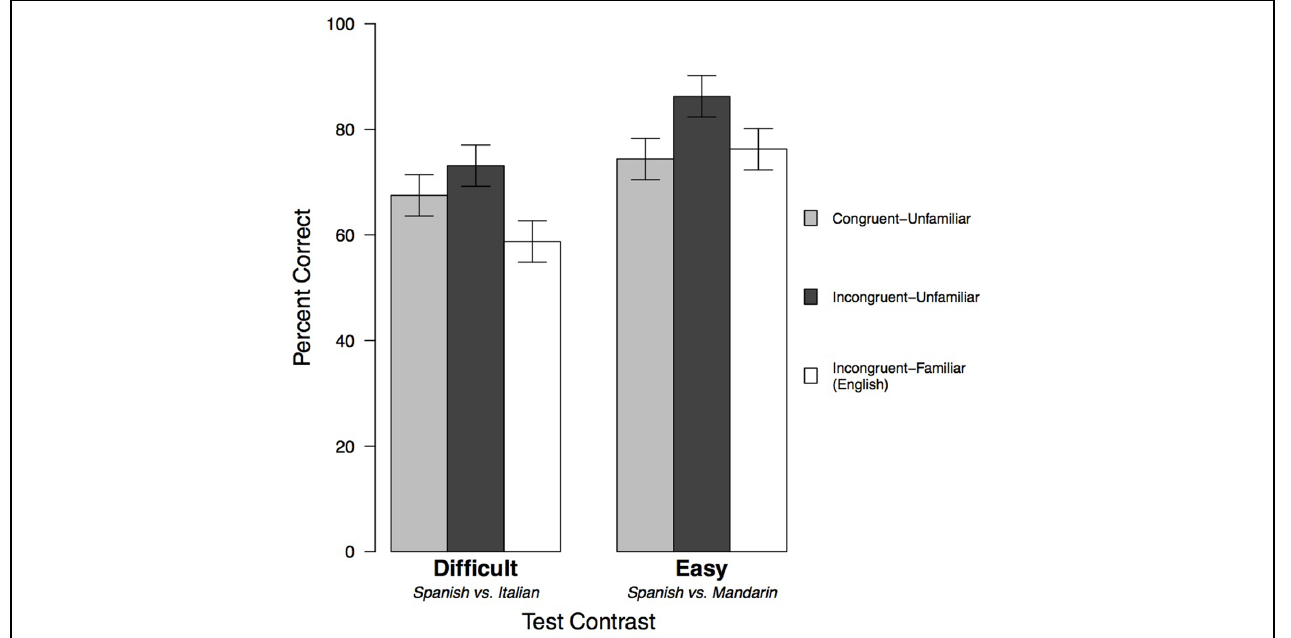
FIGURE 4 | Mean performance on the discrimination task, including data from children exposed to English in Experiment 3. For the Difficult contrast, the Incongruent-Unfamiliar exposure language was Mandarin (Experiment 1), and the Congruent-Unfamiliar Language was Italian (Experiment 2). For the Easy Exposure contrast, the Incongruent-Unfamiliar Language was Italian (Experiment 2) and the Congruent-Unfamiliar Language was Mandarin (Experiment 1). Error bars indicate standard